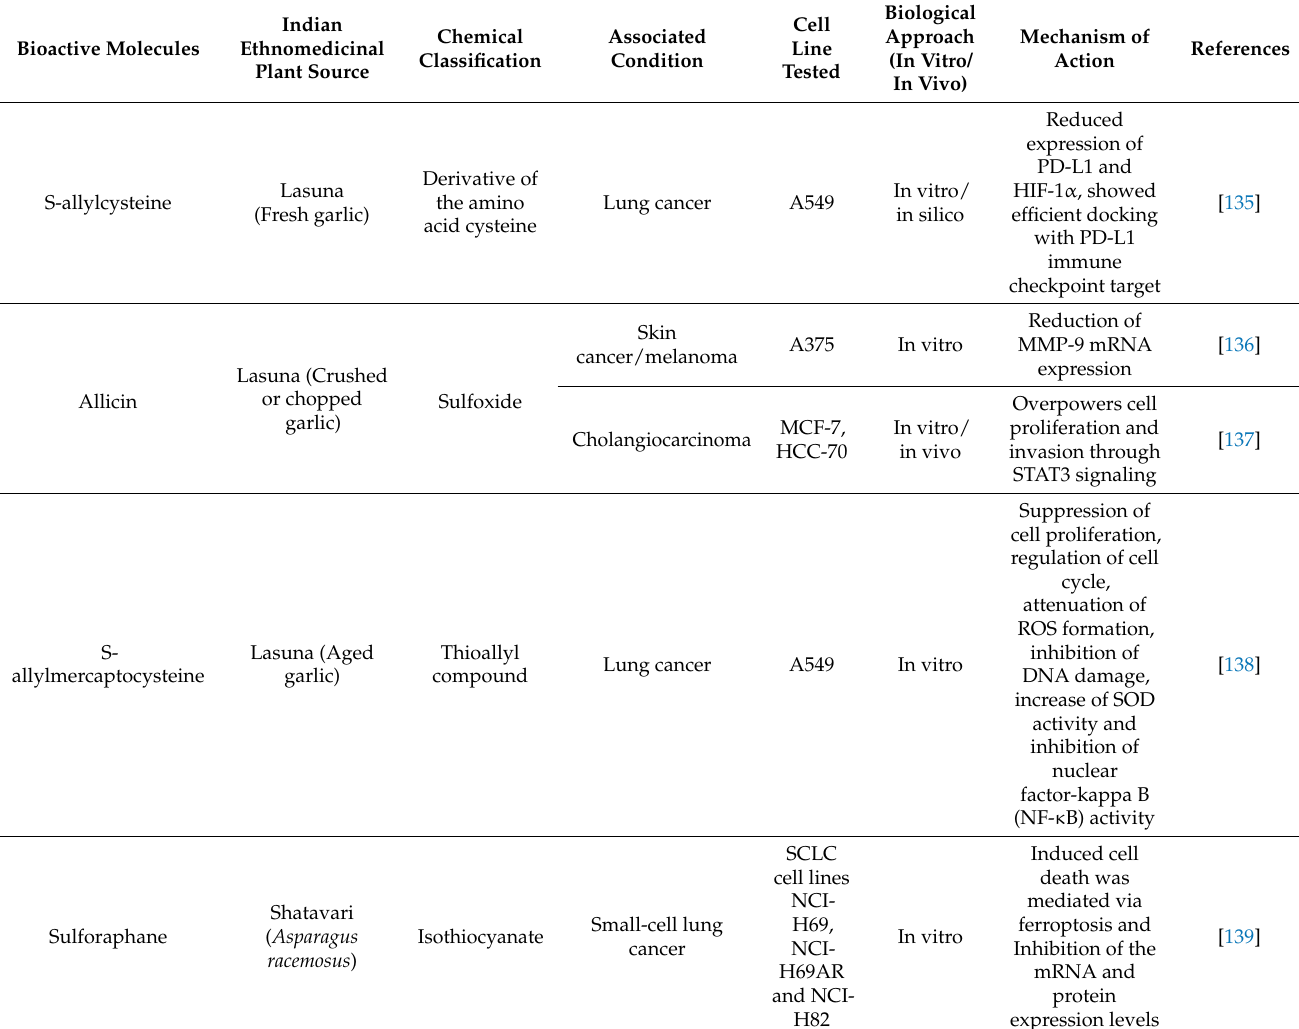
Table 5. Anticancer activity of some potent antioxidant organsulfur phytochemicals (recent data).